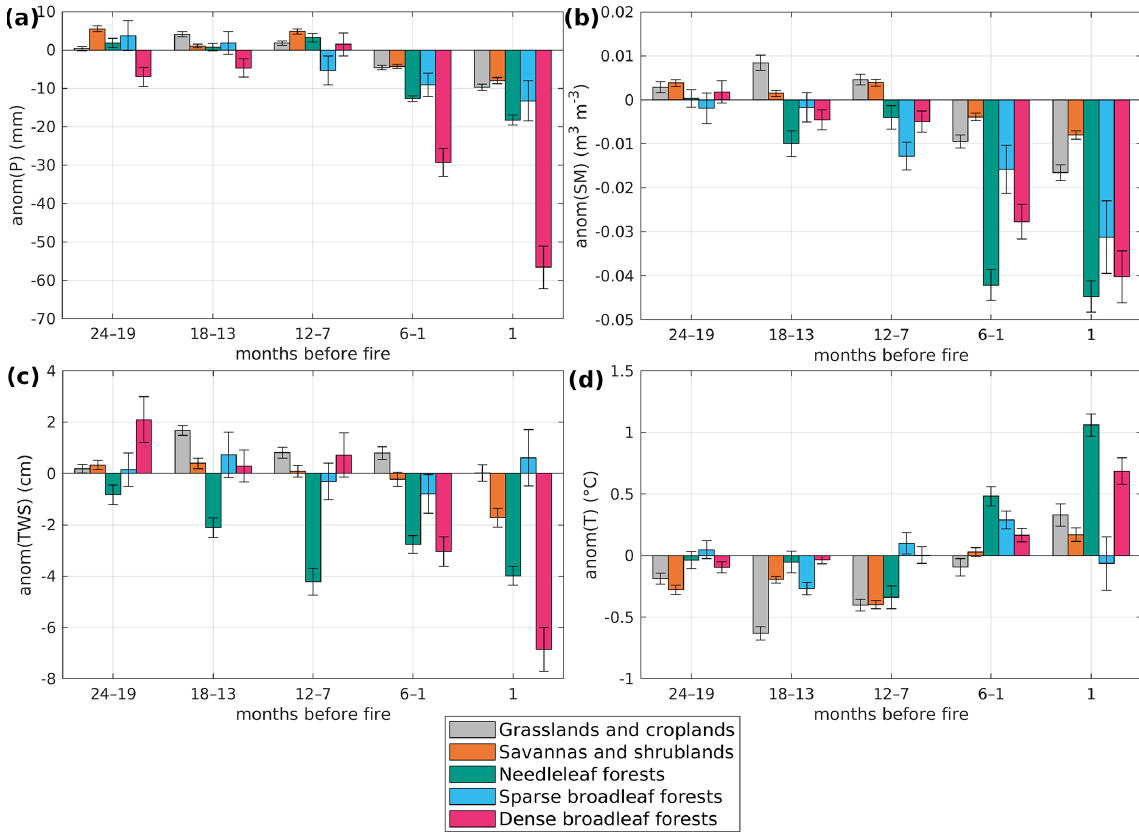
Figure 6. Anomalies of (a) precipitation, (b) SM, (c) TWS, and (d) temperature, for each ecosystem, at several pre-fire timescales. The error bars were computed with Eq.